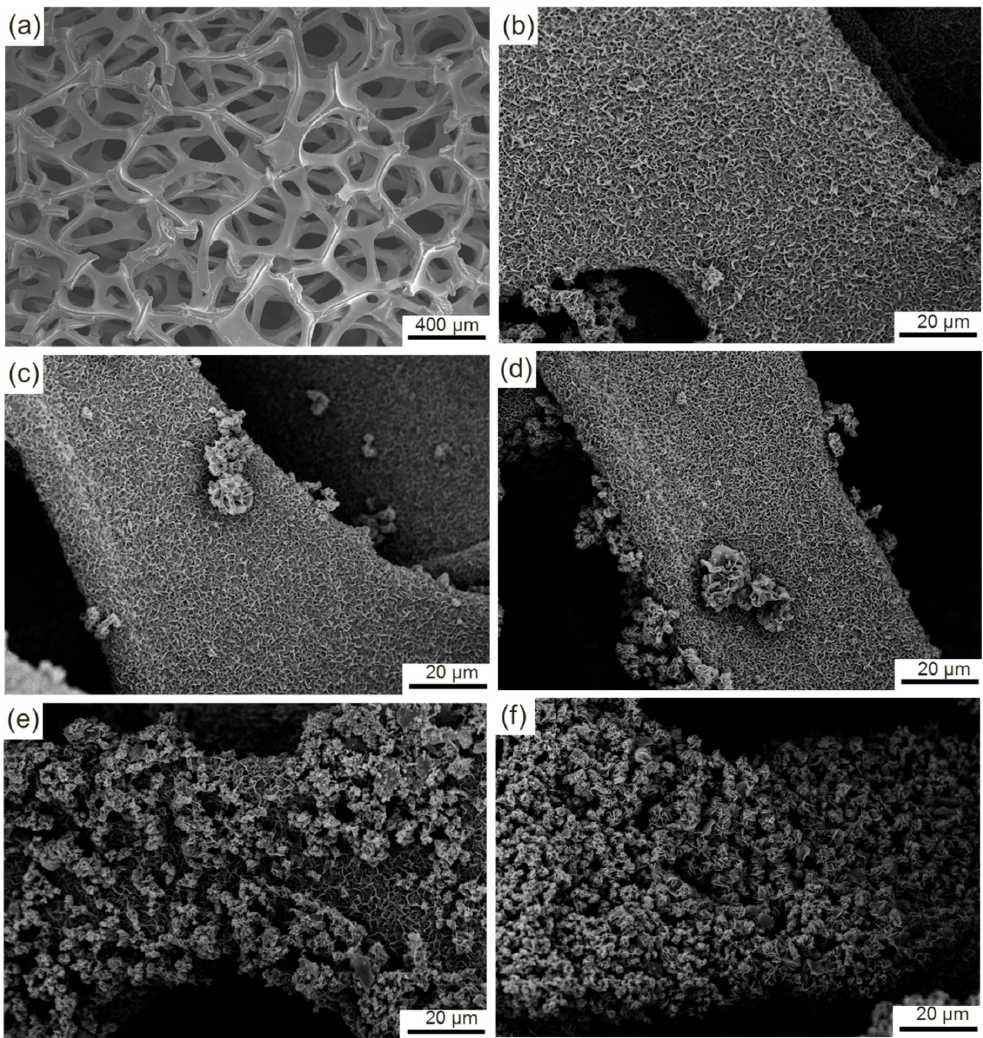
Figure 9. ( a ) SEM image of nickel foam; ( b–f ) Low magnification SEM images of samples B–F.